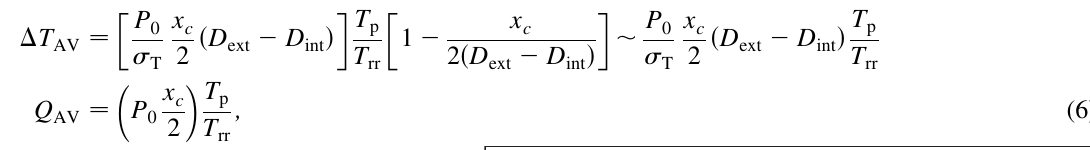
TABLE I. Parameters used for the simulations shown in Figs. 2–4. Structure parameters Pulse and thermal parameters